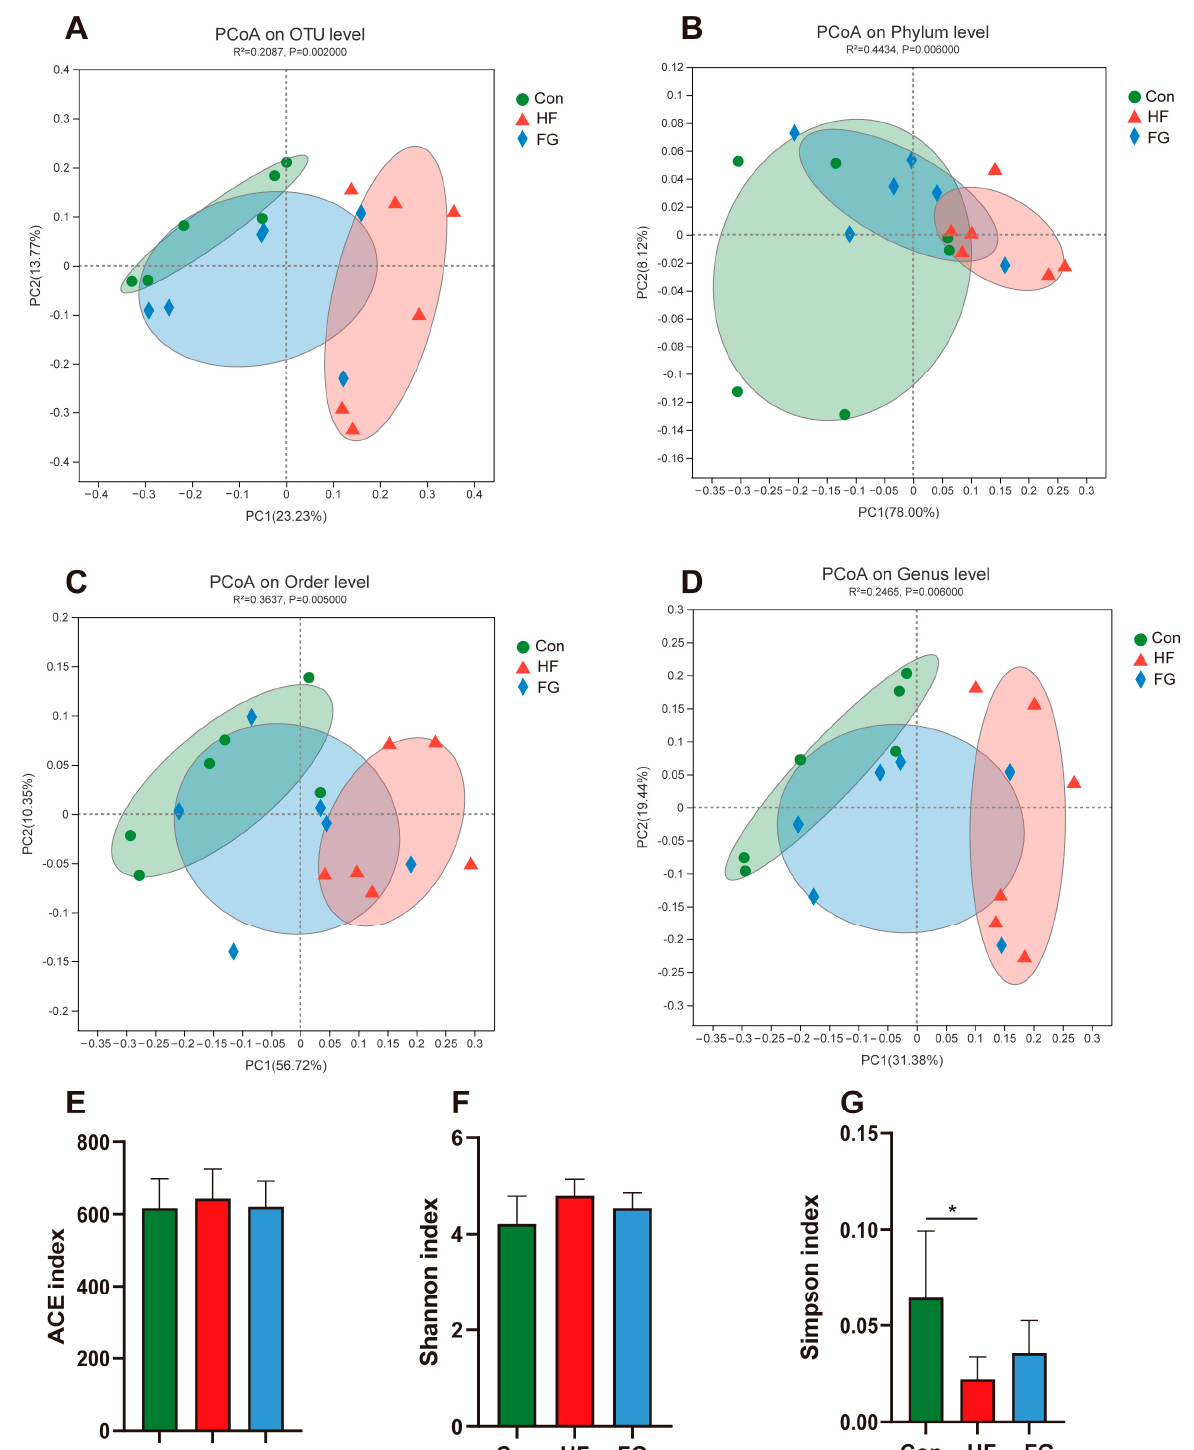
Figure 4. Analysis of intestinal microbial community diversity. Principal co-ordinates analysis (PCoA) on OTU level ( A ), phylun level ( B ), order level ( C ), genus level ( D ). Histogram for comparison of OTU diversity, ACE index ( E ), Shannon index ( F ) Simpson index ( G ). Data are presented as mean ± SD, * p < 0.05.